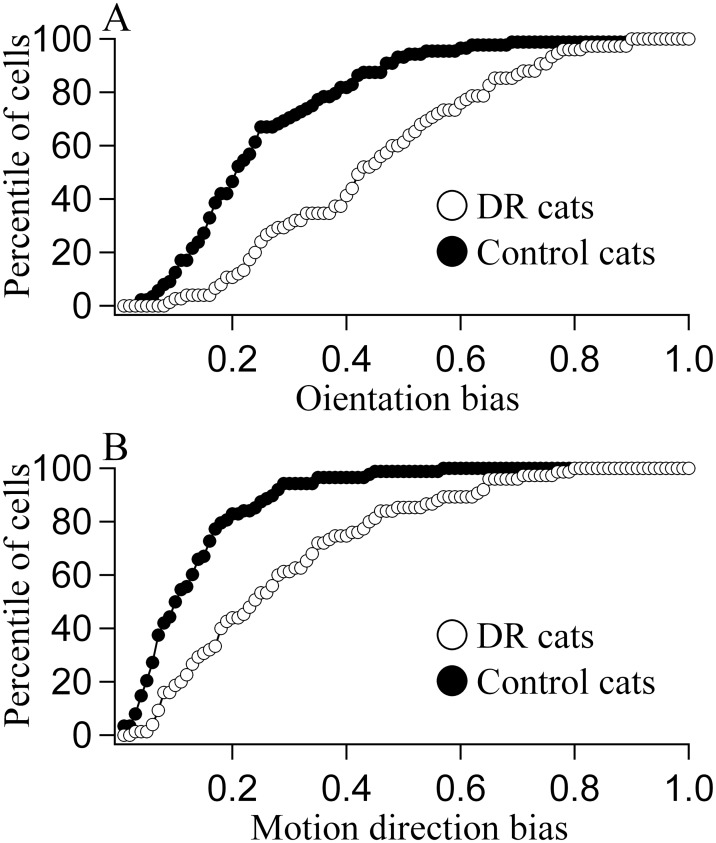
Percentile value of neurons showing different orientation bias (OB) (A) and motion direction bias (DB) (B) for DR cats (open circle) and normal control cats (solid circle).The total number of neurons was 75 and 88 respectively for DR cats and control cats. A percentile value indicated the percentage of neurons whose OBs or DBs were lower than the corresponding OB or DB value on the horizontal axis. DR cats showed significantly increased OB and DB value compared with control cats (p<0.0001; p<0.0001).